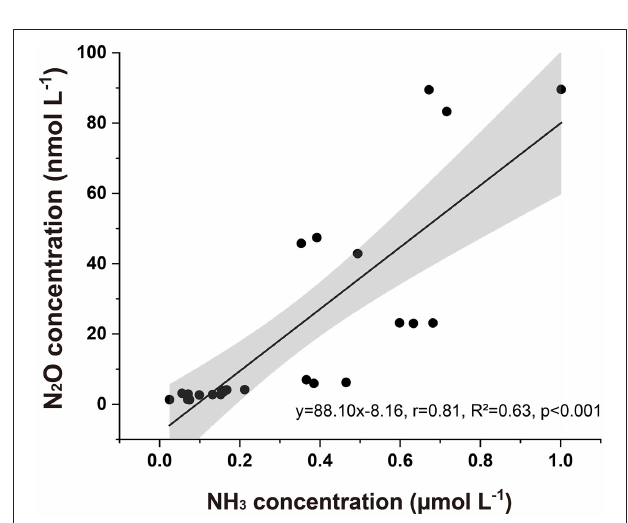
FIGURE 8 | Seawater N 2 O concentration associated with estimated NH 3 concentration after incubation. The gray area represents a 95% confidence